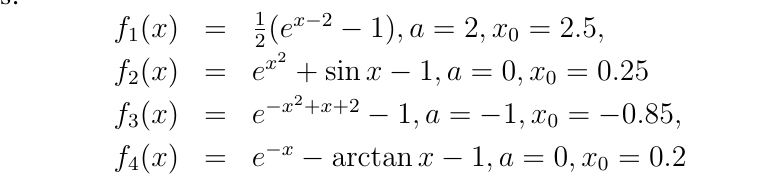
Table 2. Numerical results for f